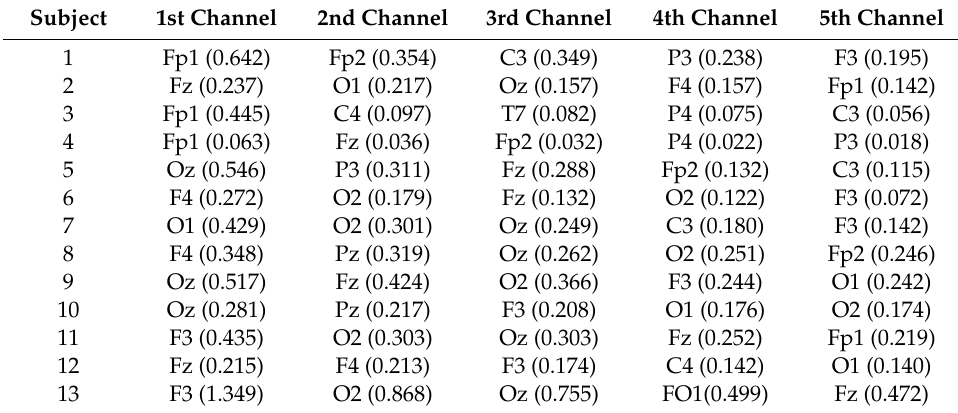
Table 2. The top five channels based on Fisher